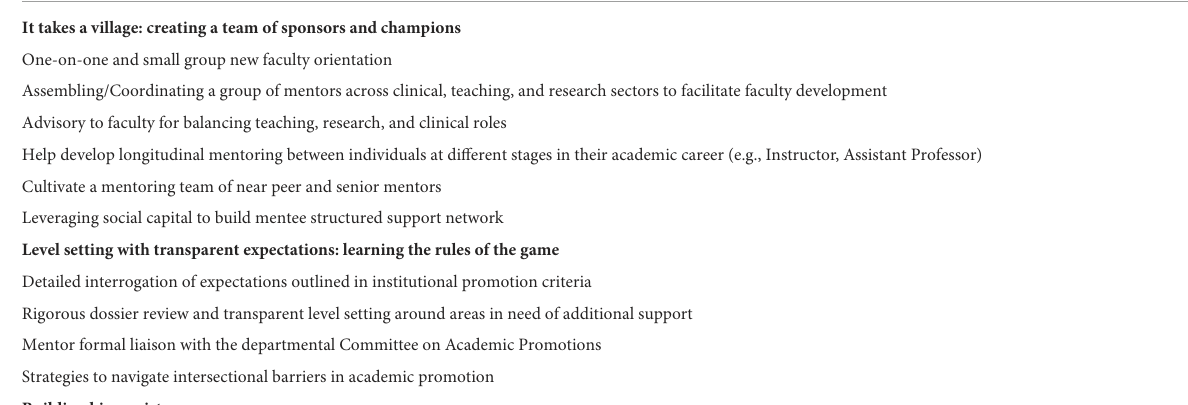
TABLE 2 Key programmatic themes of the Justice, Equity, Diversity, and Inclusion Academic Mentors (JAM) program.